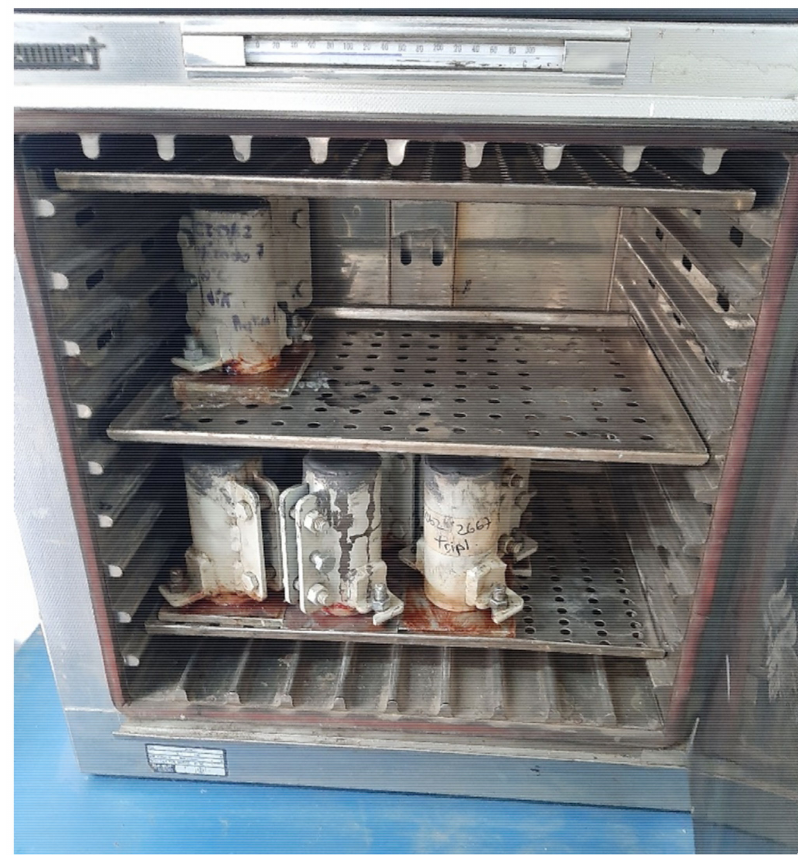
Figure 13. Test tubes in the drying